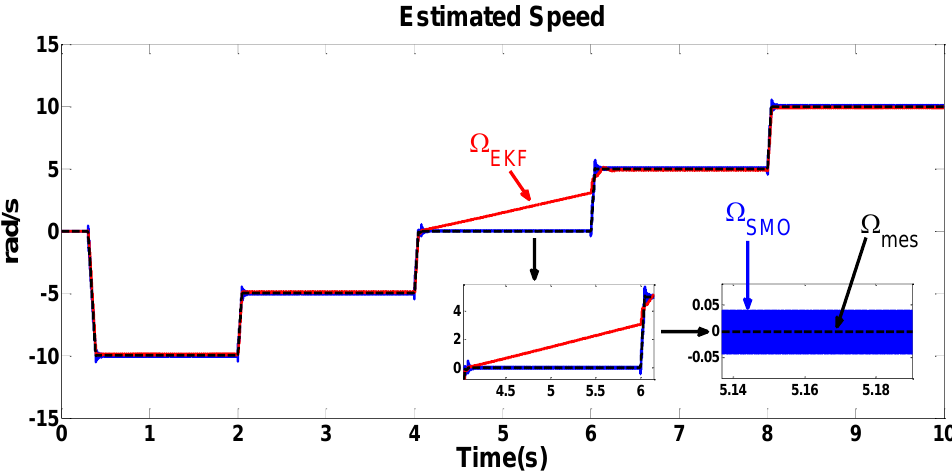
Figure 5. Estimated speed of EKF and SMO at low-velocity operation range.